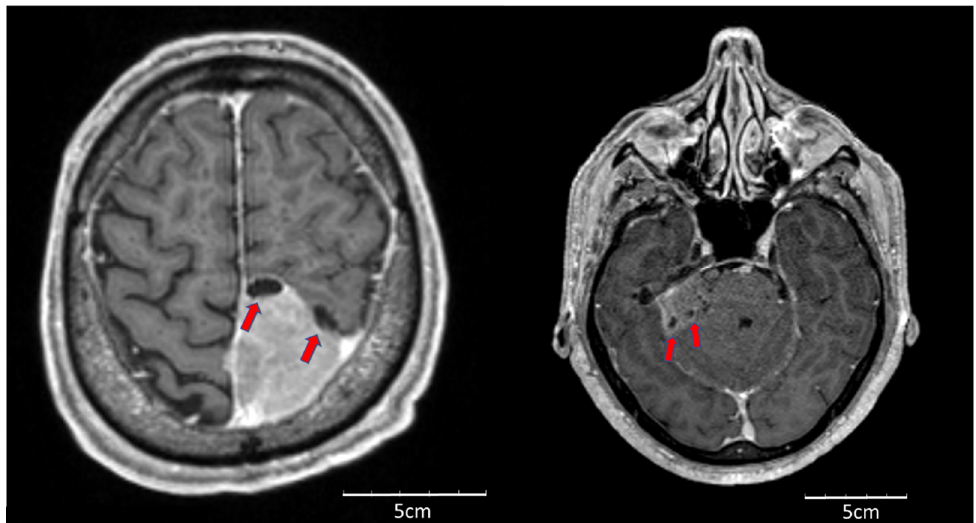
Figure 1. Cystic component within intracranial meningioma. Table 2. Univariate and multivariate analysis of semantic characteristics and selected radiomic feature (cluster prominence) for tumor recurrence.